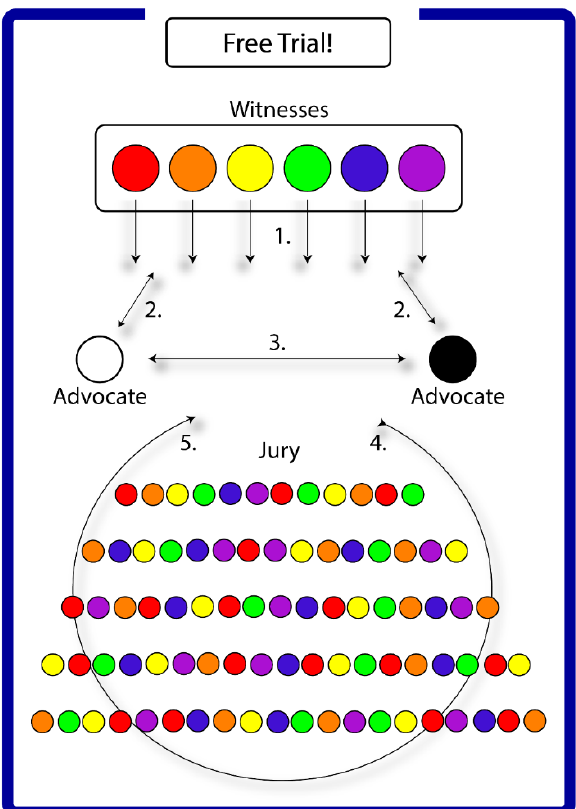
Figure 1. Free Trial! dramaturgical diagram. Source: Courtesy of